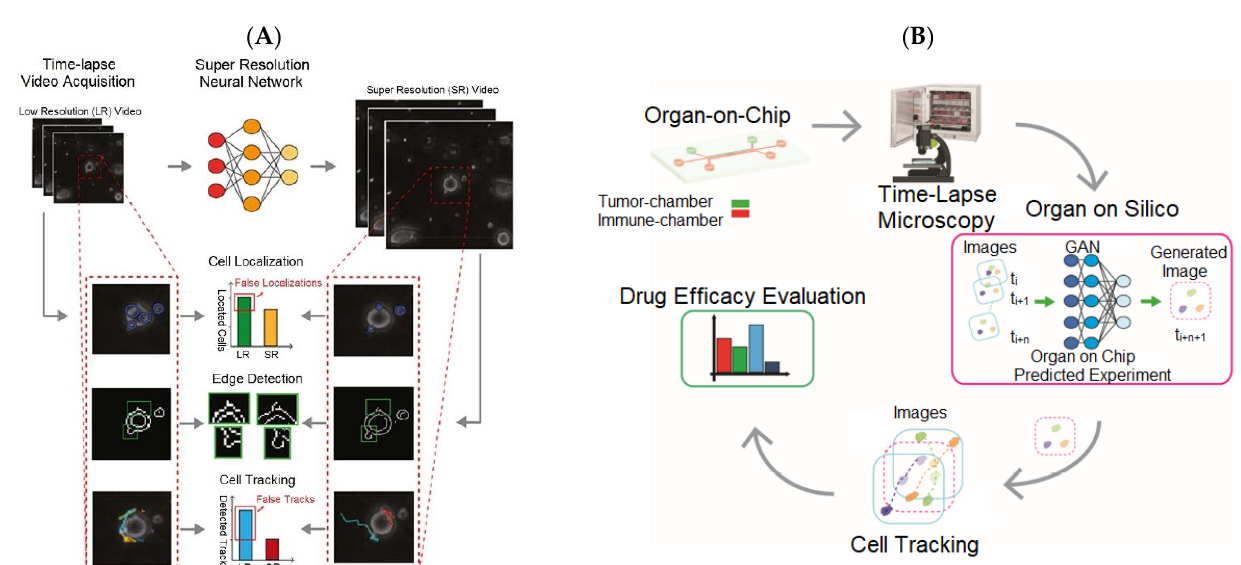
Figure 2. Application of DL in TLM videos for improving the accuracy rate of detecting cell migrations and interactions in OoC experiments. ( A ) Super-resolution method for TLM video frames. This method utilizes un-trained NN to obtain super-resolved images while fitting the input low-resolution video frames without paired training data [41]. Reproduced with permission from Elsevier Copyright (2023). ( B ) Data augmentation for TLM videos. The proposed method generates interleaved video frames for providing high-throughput TLM videos. These two methods can effectively improve the accuracy of cell tracking [43]. Reproduced with permission from Springer Nature Copyright (2023).